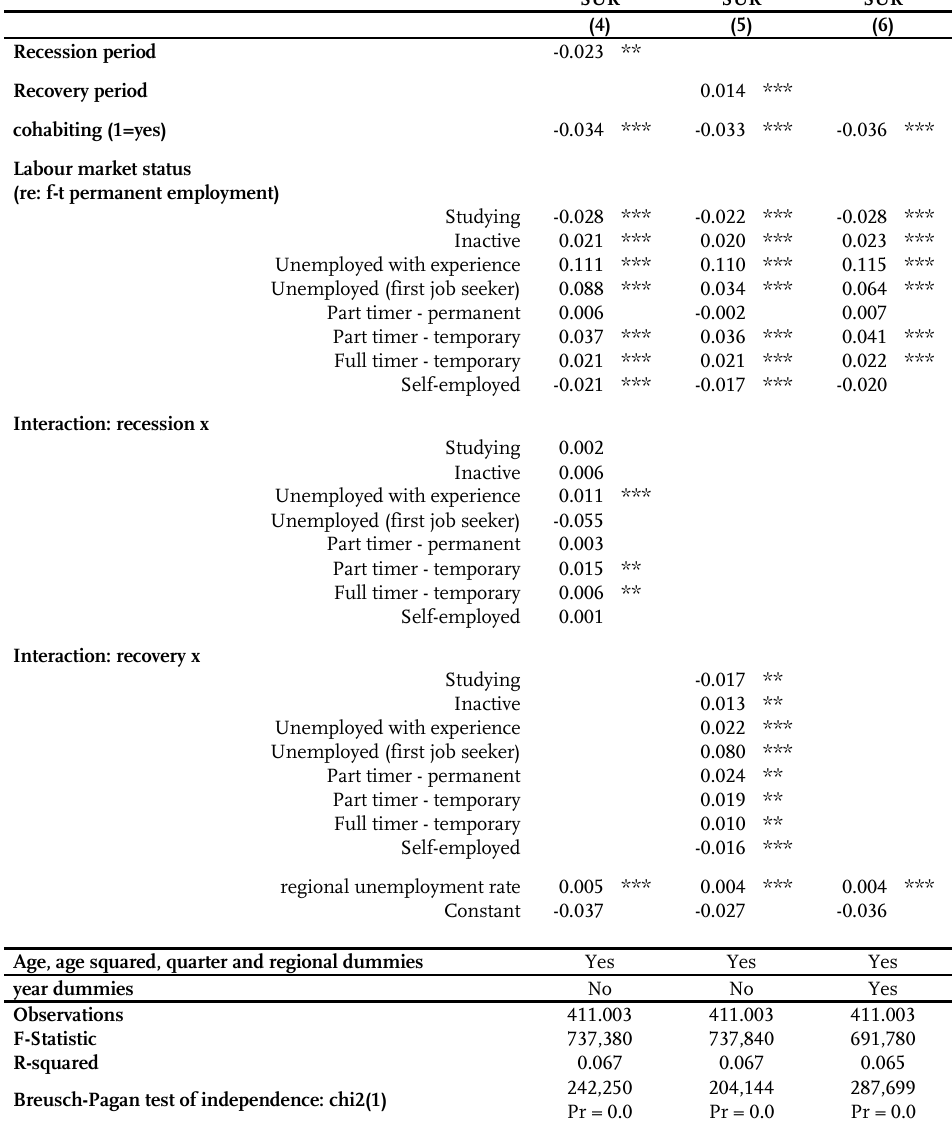
Table 4b: Seemingly unrelated regression results on household employment deprivation levels for males between 26-34 years of age. Spain. 2005-2017 SUR